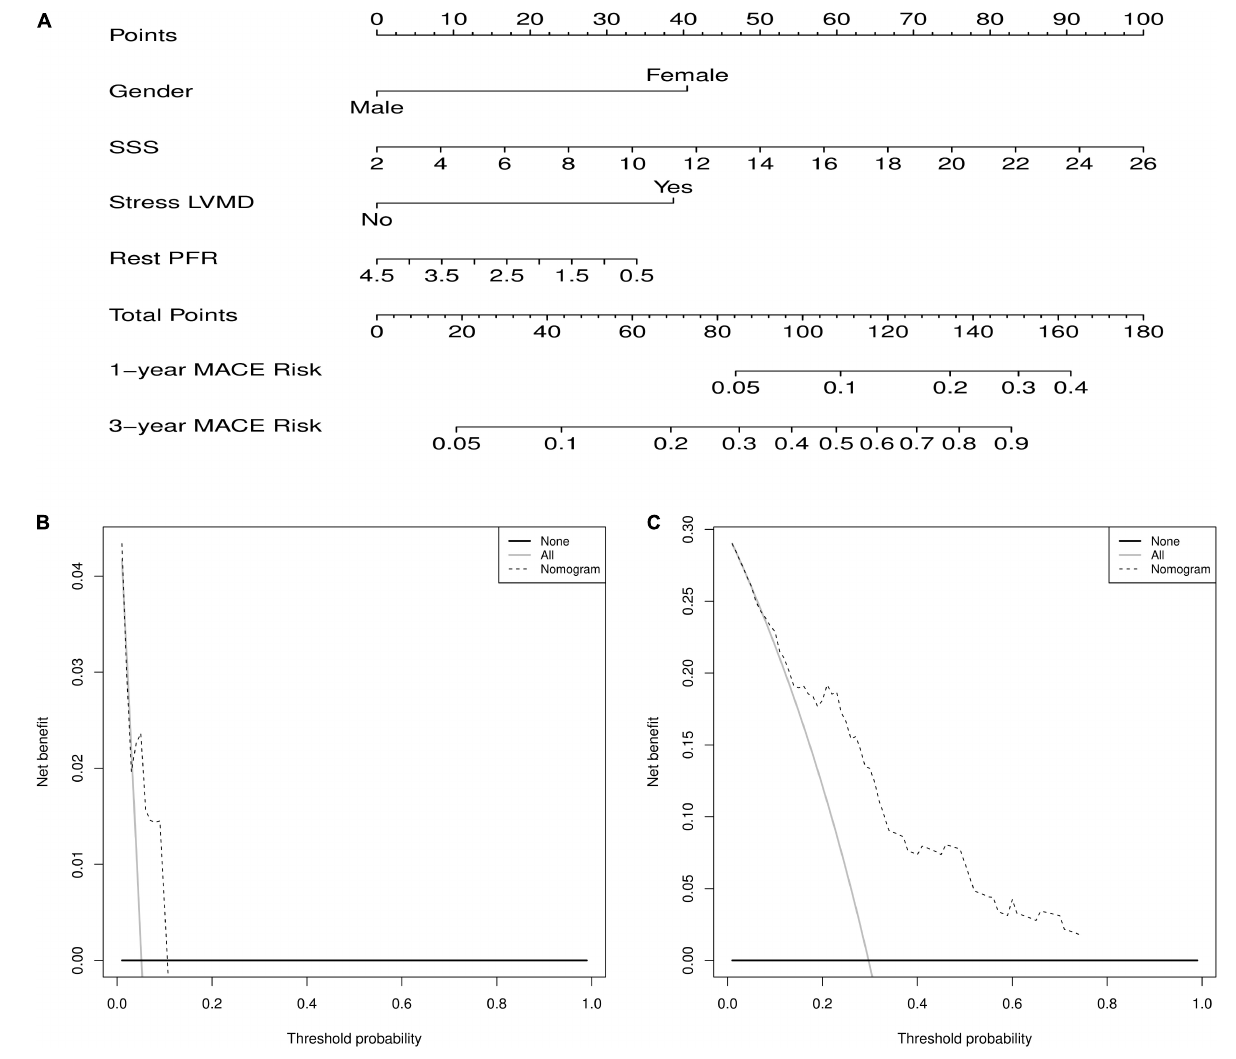
FIGURE 5 | (A) Nomogram for predicting 1 and 3 years of MACEs risk. For individualized predictions, a vertical line is drawn upward based on the patient’s characteristics to calculate the corresponding total score. The 1-year and 3-year MACEs risk is then calculated by drawing a vertical line down from “Total Points” based on the sum. (B) Decision curve analysis for 1-year predict. (C) Decision curve analysis for 3-year predict.